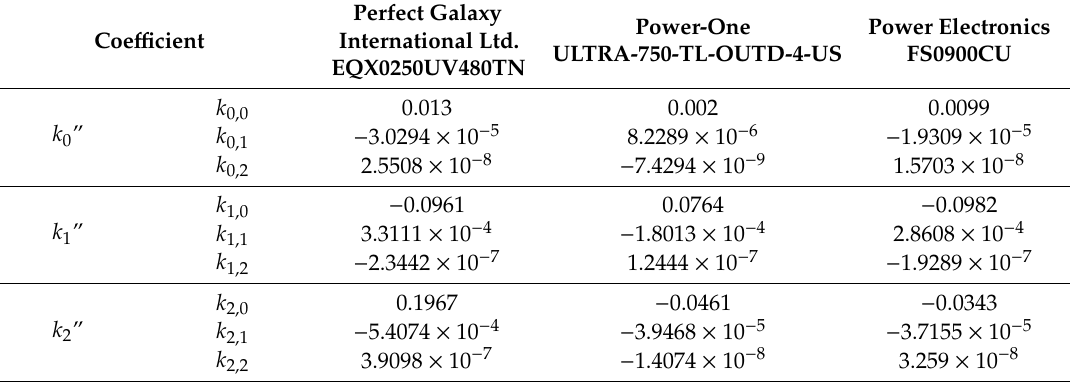
Table 8. Rampinelli nonlinear model coe ffi cients.